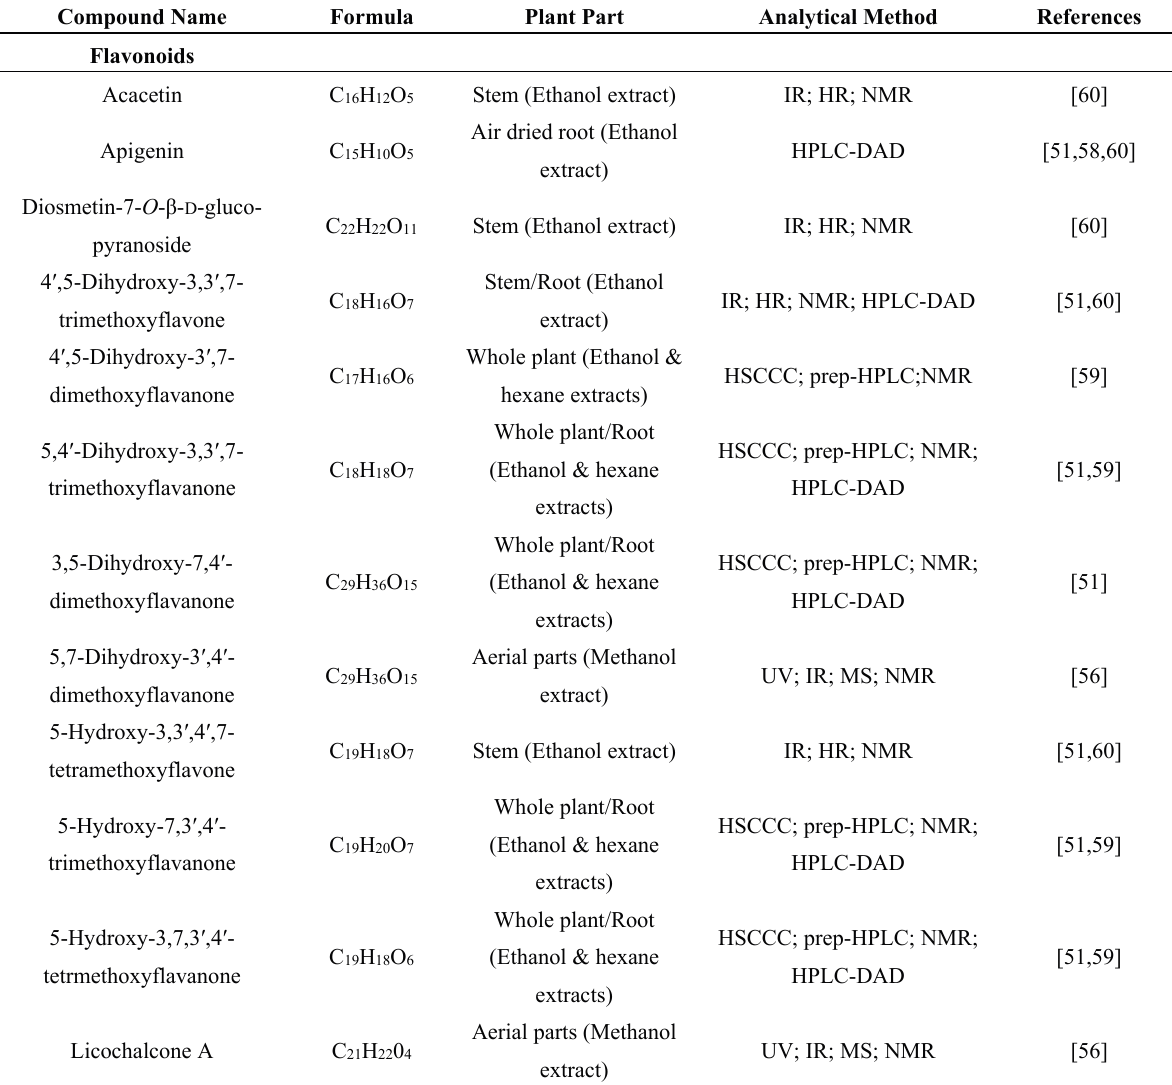
Table 2. The non-volatile constituents of P.